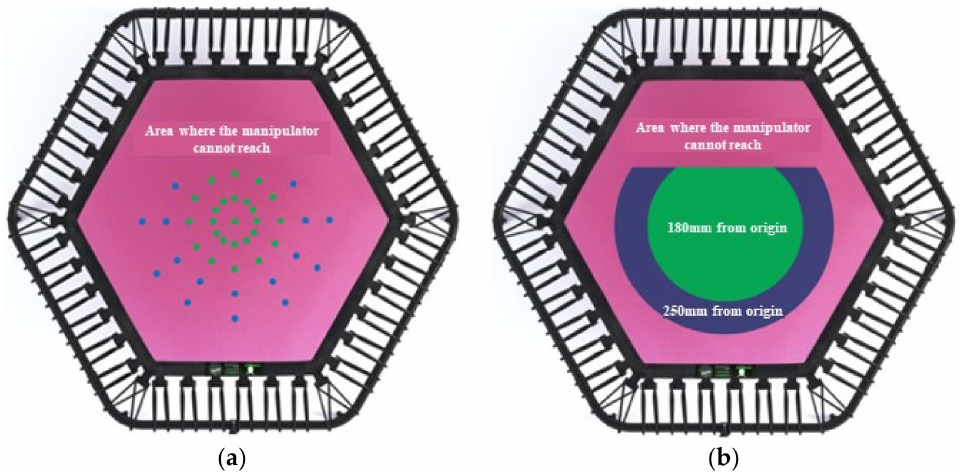
Figure 7. 2D contact positions of the manipulator on the trampoline. ( a ) Contact positions of the learning data. ( b ) Contact positions of the validation and test